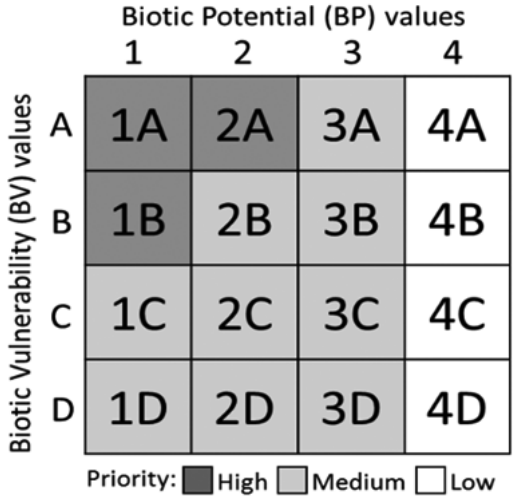
Figure 1. 16 possible alphanumerical BCVI values resulted from a combination of BP and BV scores. Cave priorities are categorized into three groups: High priority, medium priority, and Low